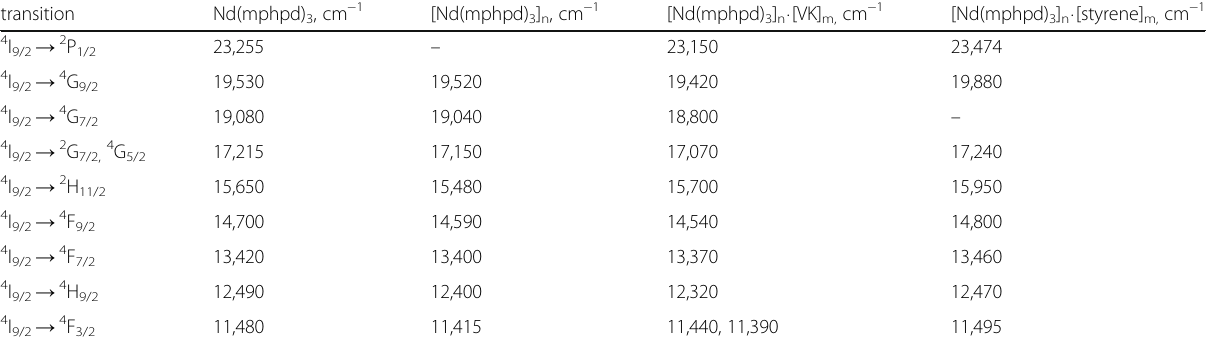
Table 3 Electronic transitions in absorption spectra of neodymium compounds transition